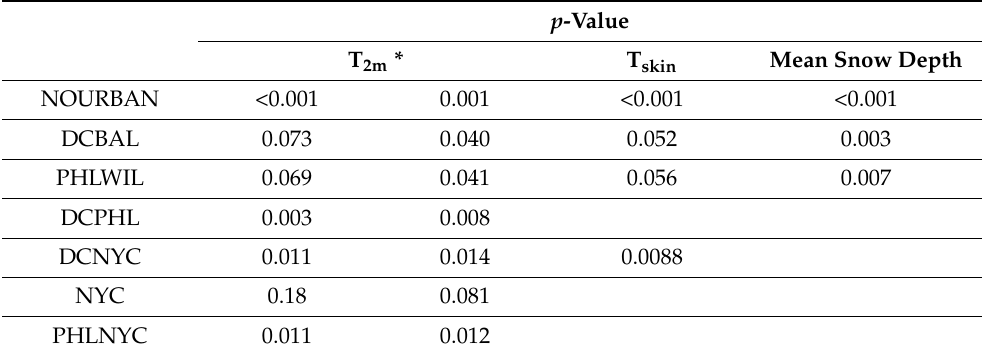
Table 2. Mann–Whitney U test probability values comparing modified datasets to the control dataset. p -values less than 0.1 (0.05) indicate that the samples are different with greater than 90% (95%) confidence. * Under T 2m , the left column is all times; the right column is during precipitation events after the primary onset at 1800 UTC on 5 February 2004. p -Value T 2m * T skin Mean Snow Depth NOURBAN <0.001 0.001 <0.001 <0.001 DCBAL 0.073 0.040 0.052 0.003 PHLWIL 0.069 0.041 0.056 0.007 DCPHL 0.003 0.008 DCNYC 0.011 0.014 0.0088 NYC 0.18 0.081 PHLNYC 0.011